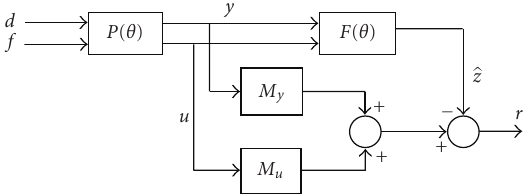
Figure 1: The general FDI filter design problem.